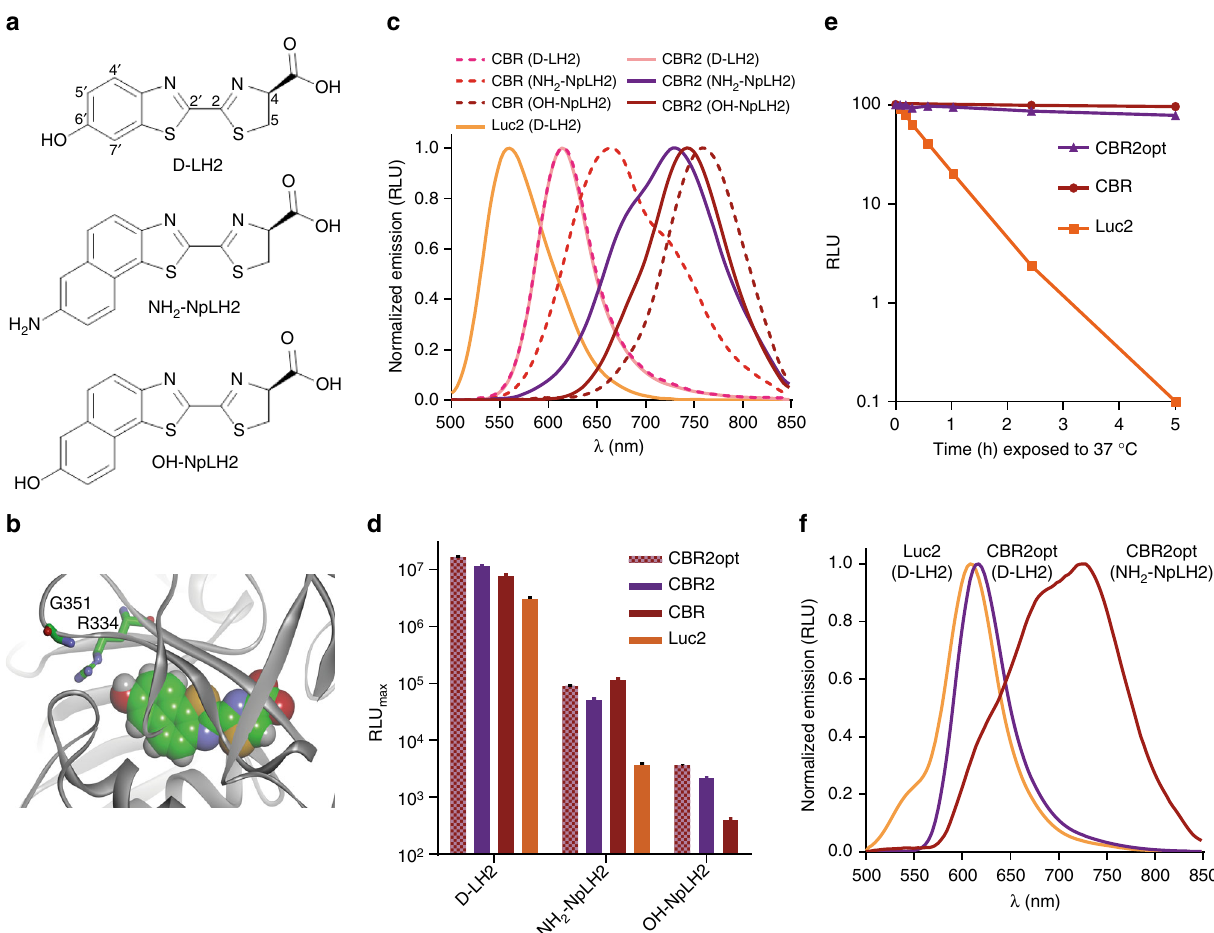
Fig. 1 Biochemical and preliminary cell-based characterization of naphthyl-luciferin bioluminescence substrates and different luciferases. a Chemical structures of NH 2 -NpLH2, OH-NpLH2, and D-LH2. The naphthyl moieties (i.e., naphtho[2,1]thiazole) provide additional π conjugation. b Homology model of CBR highlighting residues R334 and G351. c Bioluminescence emission spectra of D-LH2, NH 2 -NpLH2, and OH-NpLH2 produced by puri fi ed CBR and CBR2 (data presented as means ( n = 3) ± S.D.). Peak values for CBR are reported in Table 1. For CBR2 the peak values are as follows: D-LH2, 614 nm; NH 2 - NpLH2, 730 nm; OH-NpLH2, 743 nm. The spectrum for Luc2/D-LH2 (peak emission 559 nm) is shown for reference. d Live cell (HEK-293) bioluminescence intensity (RLU max ) for different combinations of substrate and luciferase ( n = 3). CBR2opt is a gene encoding the same CBR2 enzyme as the CBR2 gene, but it uses codons optimized for expression in mammalian cells. There was no detectable signal for Luc2/OH-NpLH2. e Physical stability of CBR, CBR2 (encoded by CBR2opt) and Luc2 in HEK-293 lysates at 37 °C ( n = 3). f Bioluminescence emission spectra of D-LH2 and NH 2 -NpLH2 produced by CBR2opt and Luc2 cells (HEK-293). Emission peaks: Luc2/D-LH2, 608 nm; CBR2opt/D-LH2, 617 nm; CBR2opt/NH 2 -NpLH2, 728 nm. The signal for Luc2/NH 2 -NpLH2 was too low to generate meaningful spectral data. Attempts to collect spectra for OH-NpLH2 were also unsuccessful due to insuf fi cient signal. Error bars represent standard deviation